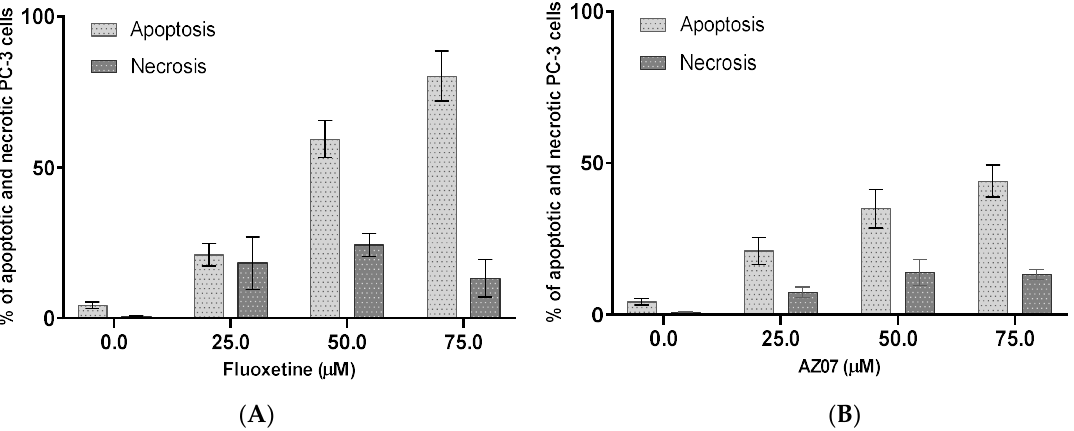
Figure 4. Induction of apoptosis (sum of early and late apoptosis) and necrosis in PC-3 prostate cancer cells after 72 h of incubation with fluoxetine ( A ) and compound AZ07 ( B ).